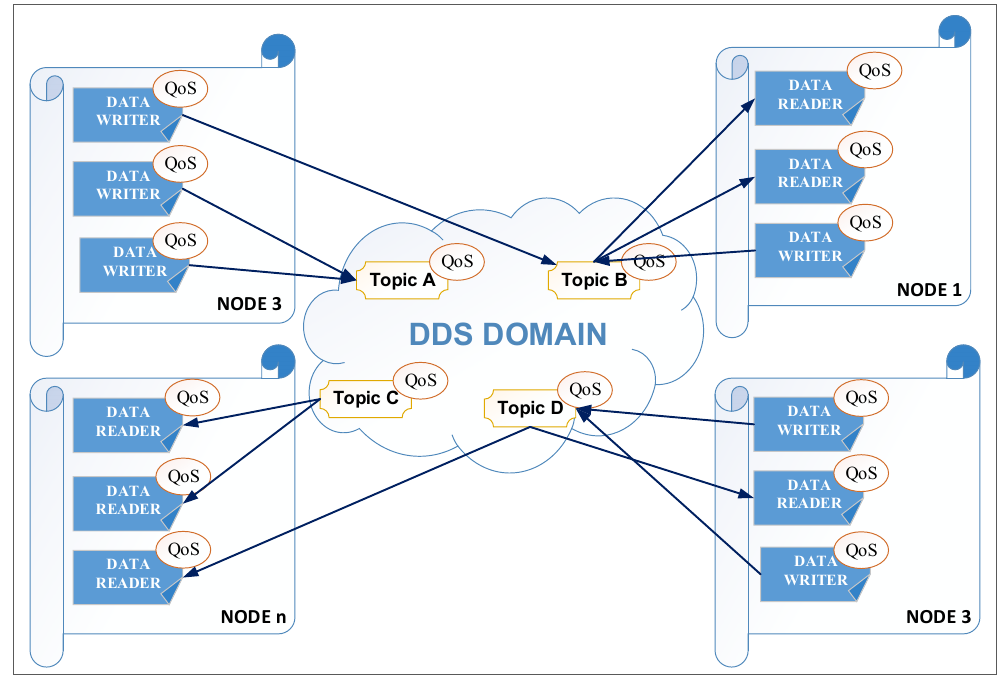
Figure 6. Interactions between things in a data distribution service (DDS) domain.